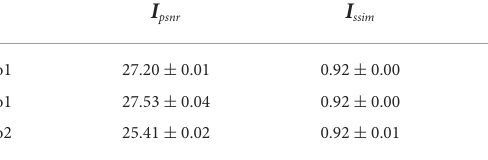
TABLE 8 Testing result of flexible plant prediction